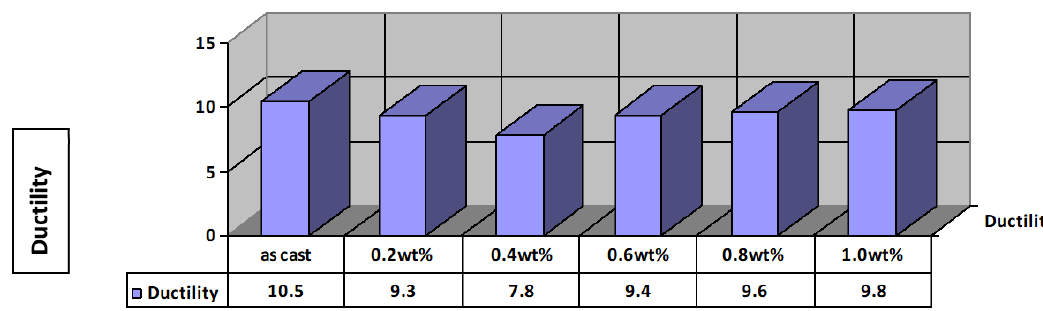
Tensile Strength and Yield Stress (0.2 offset)